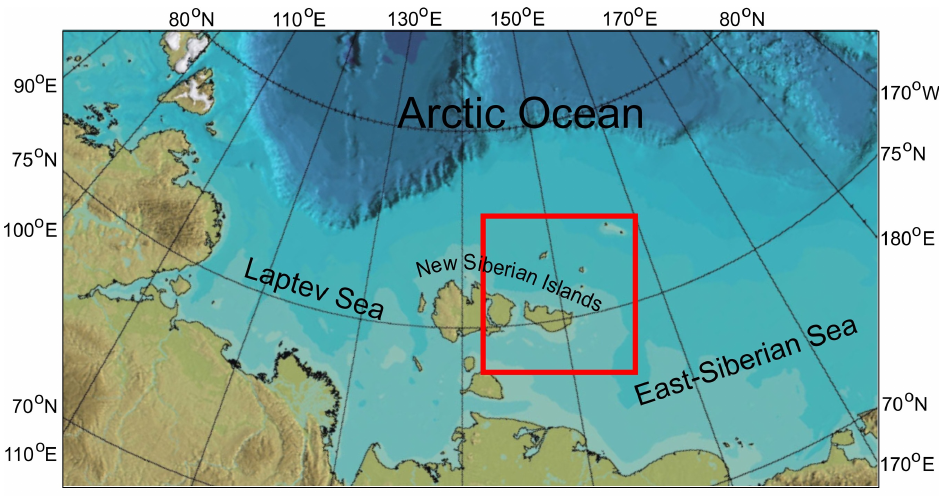
Figure 1. Area of the gas hydrate